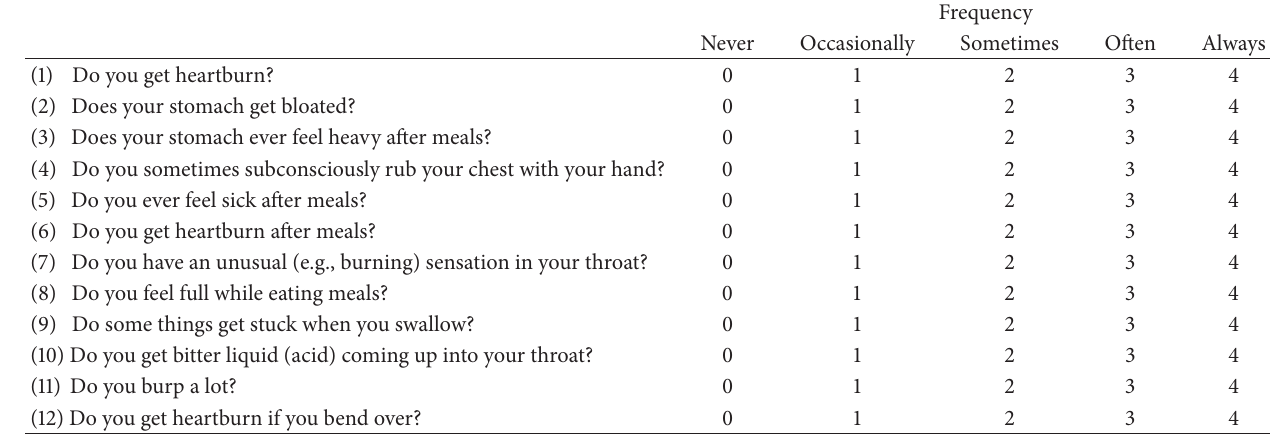
Table 1: The frequency scale for symptoms of gastroesophageal reflux disease.